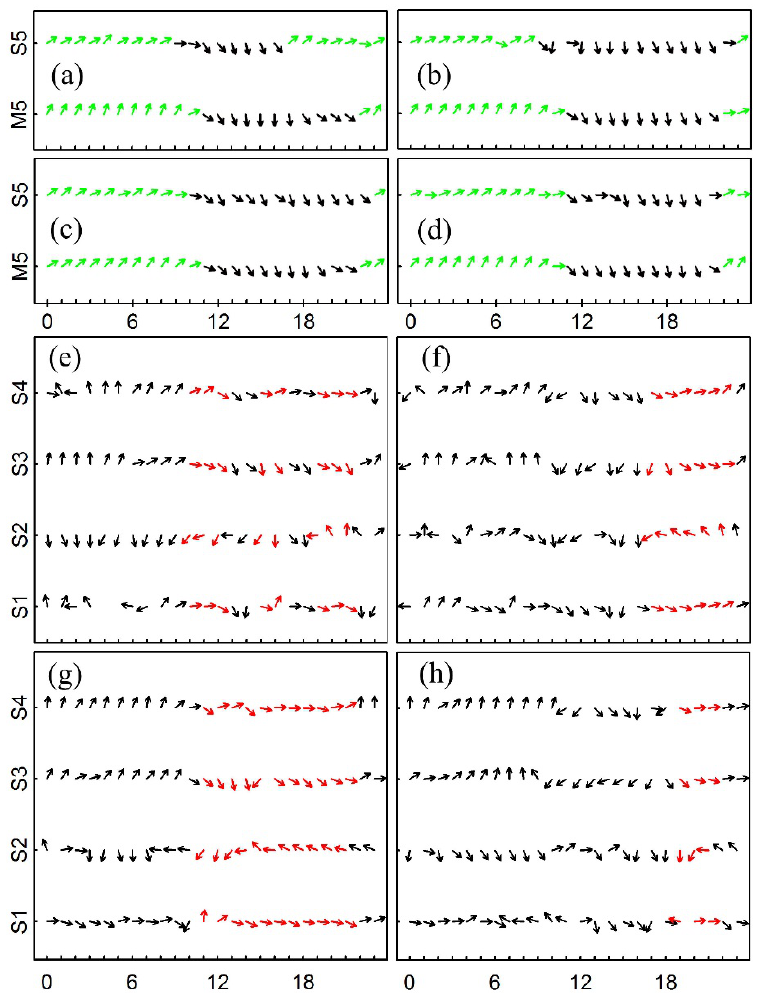
Figure 6. The observed (S5) and simulated (M5) hourly wind direction in the mountain station and the hourly observed wind direction in the oasis boundary stations (S1–S4). ( a – d , e – h ) present the four days: 9, 10, 11 and 12 of June 2016; the green arrows present the mountain wind and the black arrows present the plain wind ( a – d ); the red arrows show the obvious period where a divergent flow is observed ( e – h